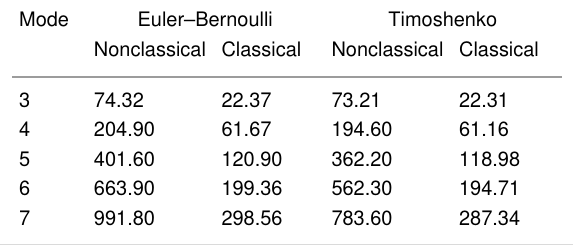
Table 5: Dimensionless natural frequencies of the cylindrical gold nanoparticle with length of 25 μ m and aspect ratio of 30.